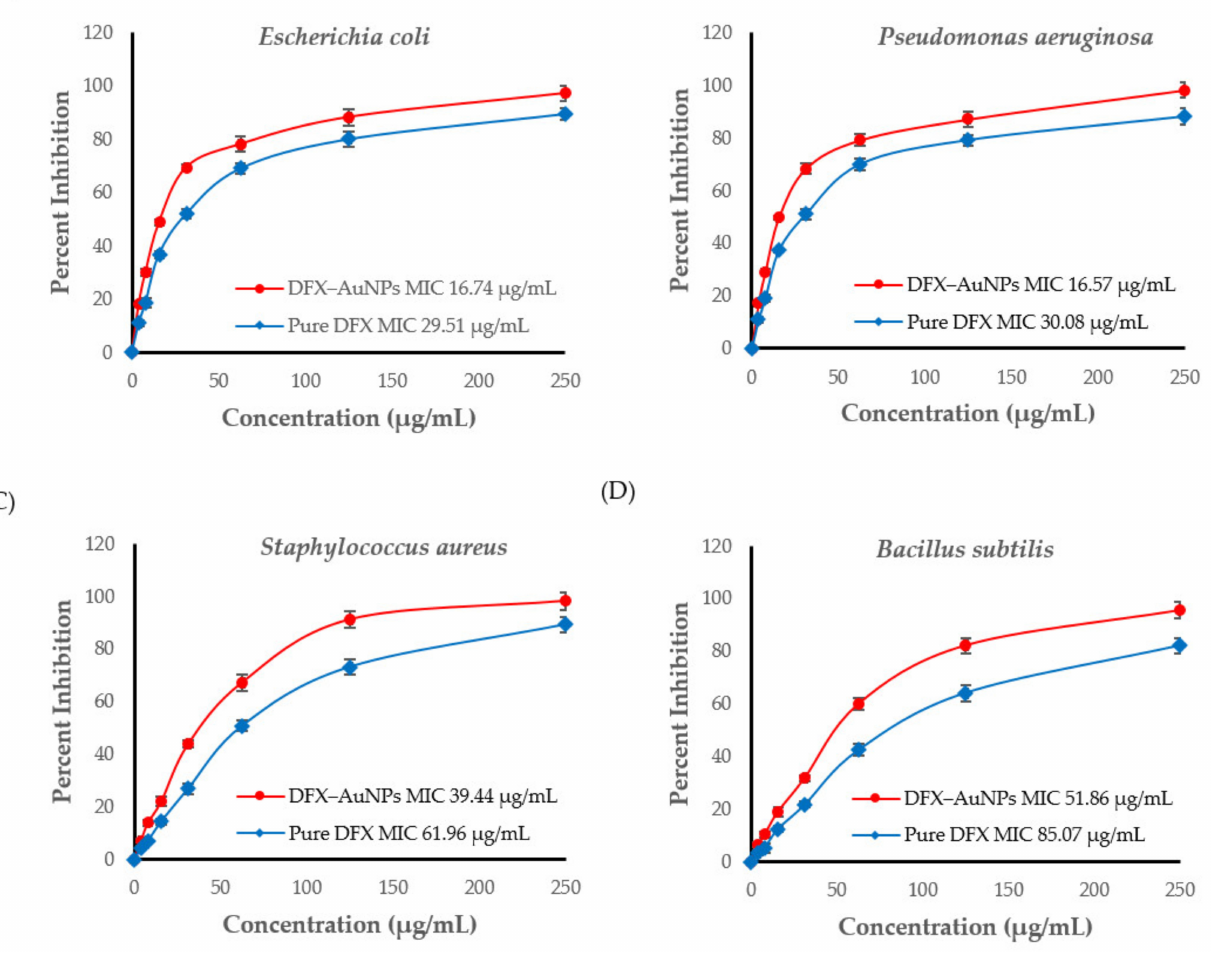
Figure 6. Minimal inhibitory concentration (MIC) curves of DFX and DFX-AuNPs obtained against ( A ) Escherichia coli ; ( B ) Pseudomonas aeruginosa ; ( C ) Staphylococcus aureus and ( D ) Bacillus subtilis . Data represent mean ± standard deviation of three independent experiments conducted under identical experimental